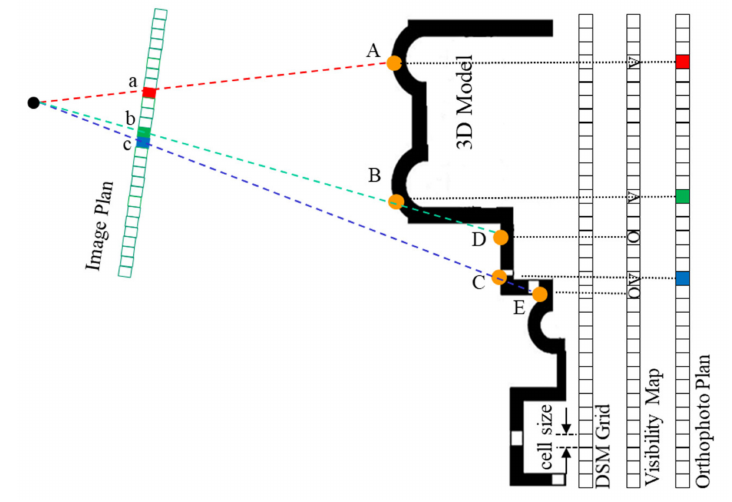
Figure 16. Principle of true orthophoto